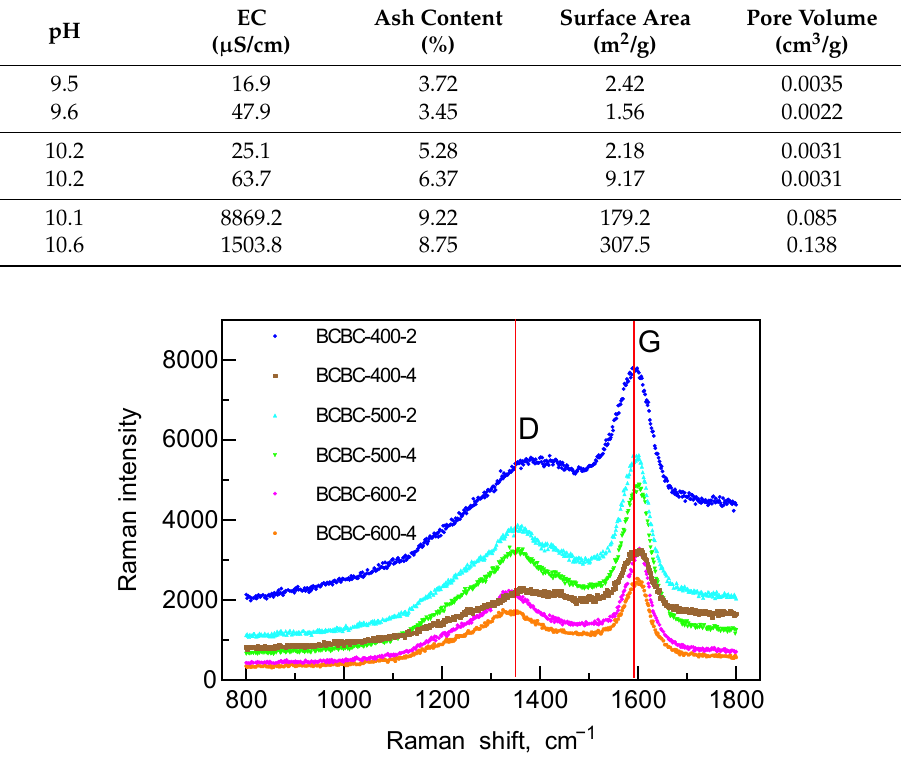
Figure 2. Raman spectra of the biochars.